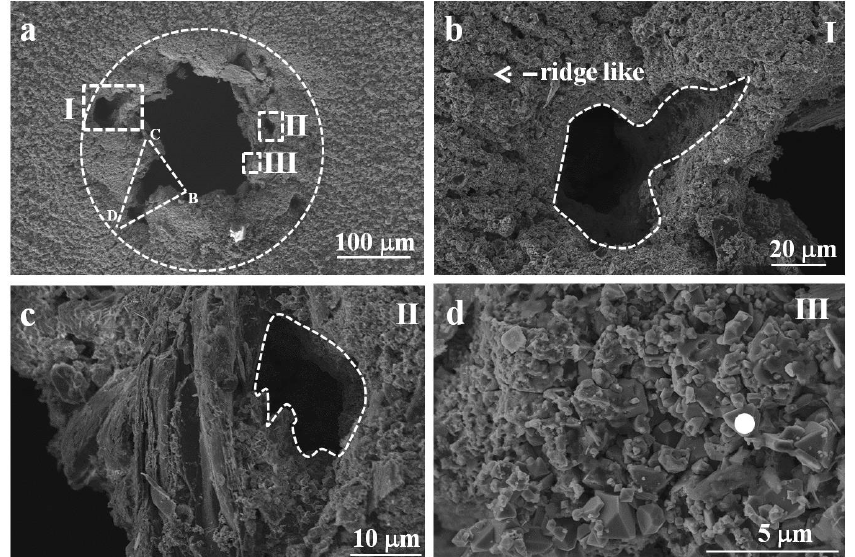
Figure 4. ( a ) The surface morphology of the micro-orifice observed by SEM after 500 h of immersion at 290 °C. ( b – d ) The magnified surface morphology indicted respectively in the rectangle regions Ⅰ , Ⅱ , and Ⅲ in the Figure 4a. A composition of the point in Figure 4d was analyzed by EDS.